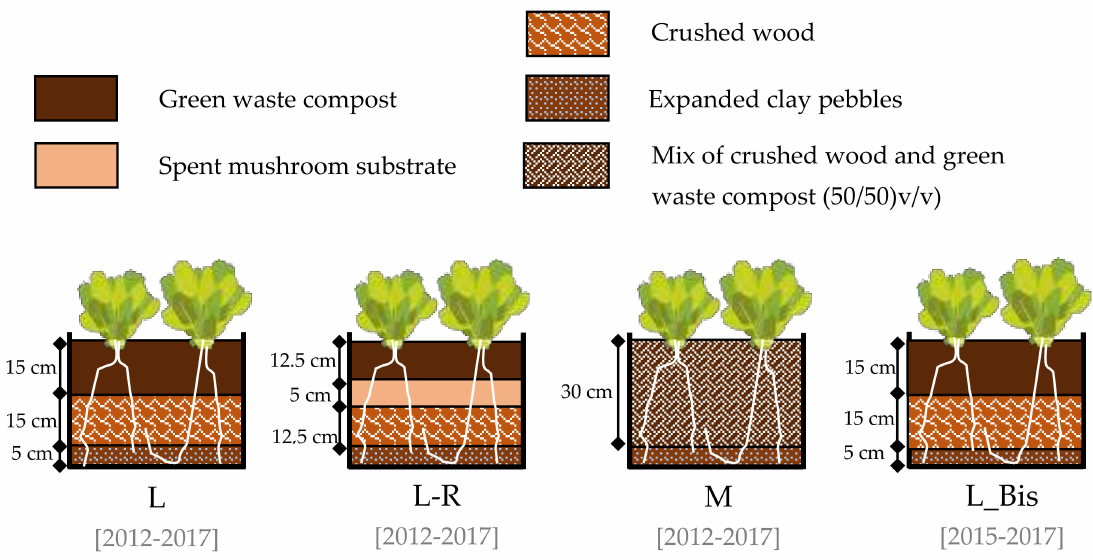
Figure 3. Scheme of the di ff erent experimental